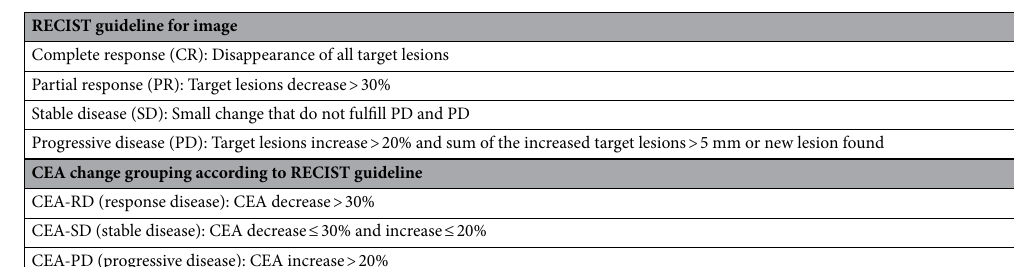
Table 1. The definition of RECIST guideline for image and for CEA in this study.